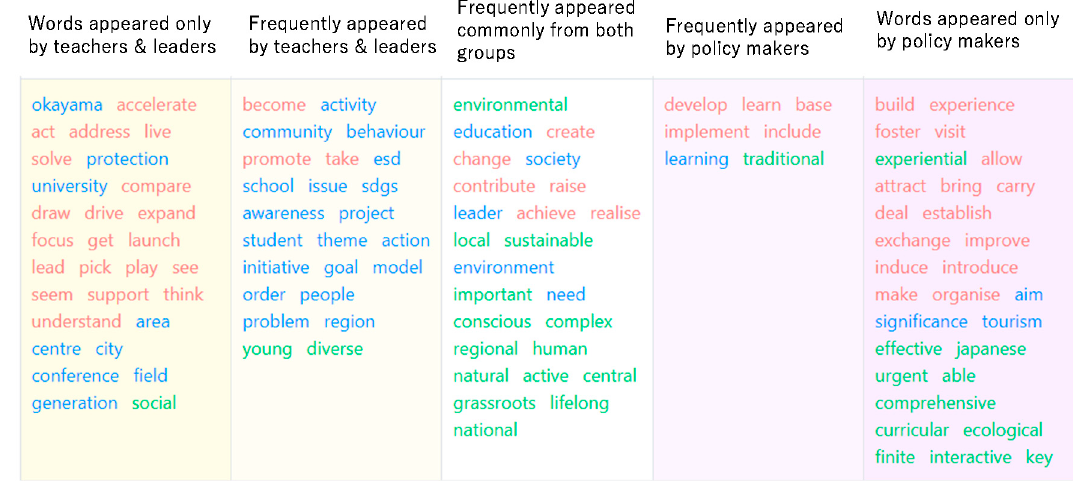
Figure 8. Comparative overview of frequent words of teachers, leaders, and policymakers.